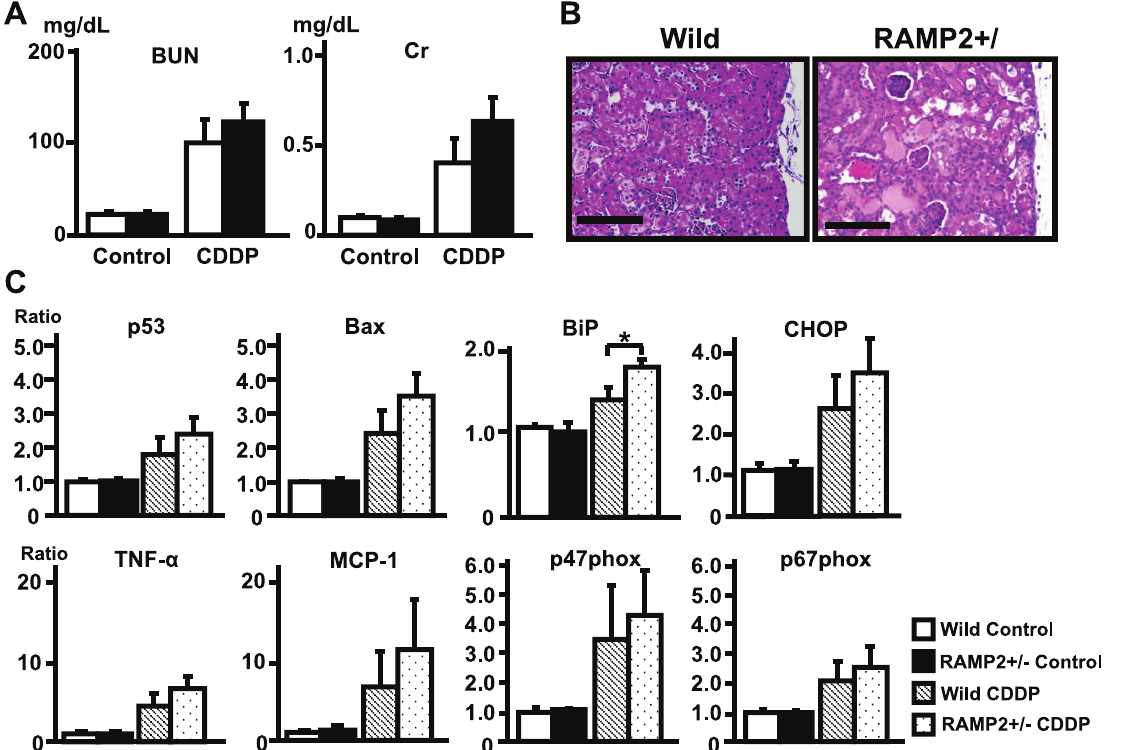
Figure 9. Cisplatin induces enhanced renal injury in RAMP2 + / 2 . (A) Serum BUN and creatinine (Cr) in wild-type and RAMP2 + / 2 3 days after administration of vehicle (Control) or cisplatin (CDDP) (20 mg/kg). (B) H&E staining of the renal cortex in CDDP-treated wild-type and RAMP2 + / 2 kidneys. Scale bars=100 m m. Sections from RAMP2 + / 2 kidneys showed severe tubular injury. (C) Quantitative real-time PCR analysis of the indicated gene expression. Data from the wild-type control group were assigned a value of 1. n=5 in each group. Bars are means 6 SEM. *p ,